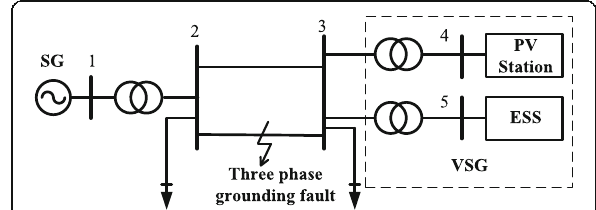
Fig. 7 Two-machine two-area system with PV-VSG integration